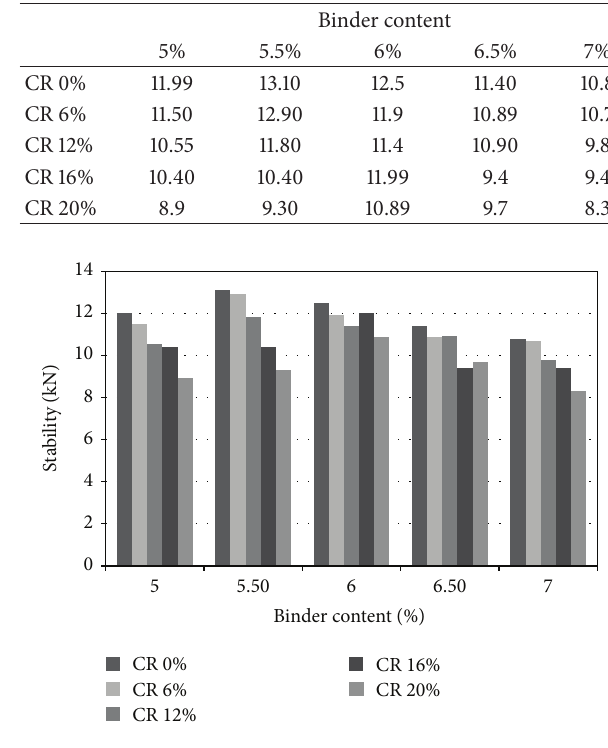
Figure 1: Stability results versus binder